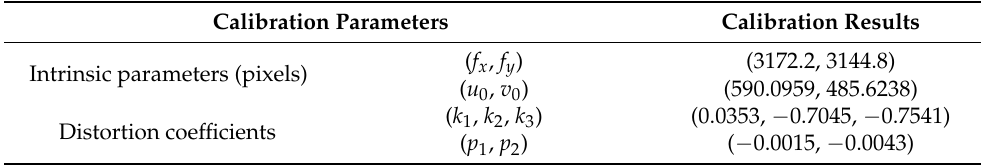
Table 1. Results of the calibration of intrinsic parameters and distortion coefficients.